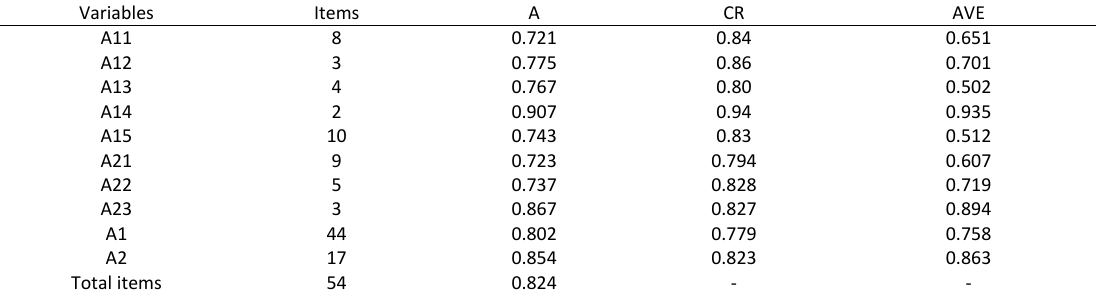
Table 4. Combined reliability and convergent validity of the research Variables Items A CR AVE